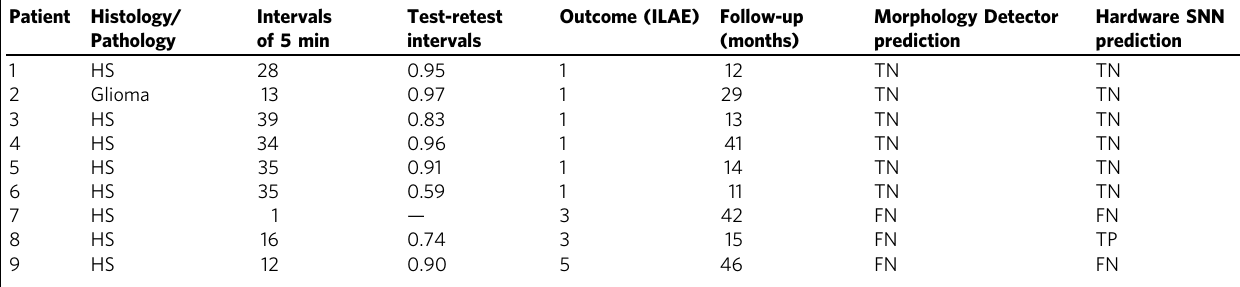
Table 1 Patient characteristics and postsurgical seizure outcome. We “ predict ” seizure outcome for each patient based on resection of the HFO area that was delineated by the Morphology Detector 31 and the hardware SNN of our system. The hardware SNN prediction was correct in 7/9